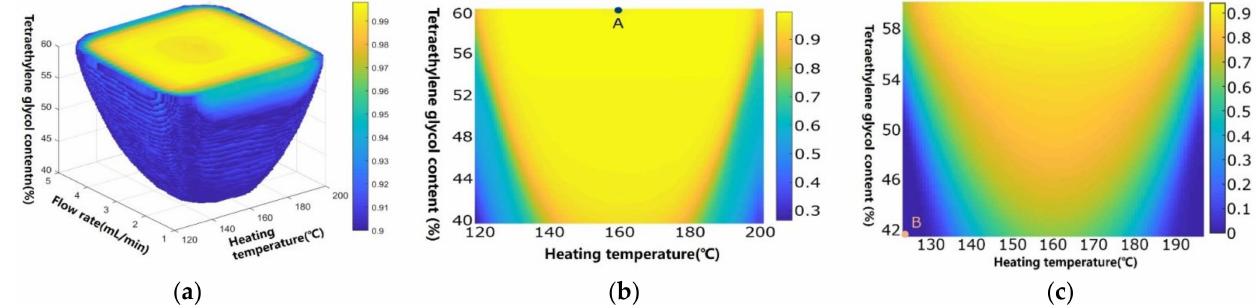
Figure 9. Design space and the verification of experimental conditions. Different colors in the figure indicate different probabilities of reaching the design space, and the colored bar indicates the probability values. ( a ) Raw material content = 5%, ethylenediamine content = 50%; ( b ) Raw material content = 5%, ethylenediamine content = 50%, flow rate = 3 mL/min; ( c ) Raw material content = 5%, ethylenediamine content = 50%, flow rate = 1